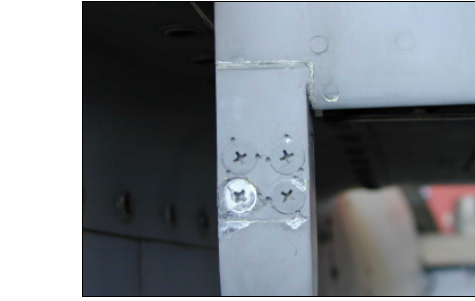
Рис .14 – Гальваническая коррозия на MB-339 между опорой из Mg сплава и аллюминиевыми заклепками Figure 14 – Galvanic corrosion on the MB-339 between an Mg alloy trim and aluminum